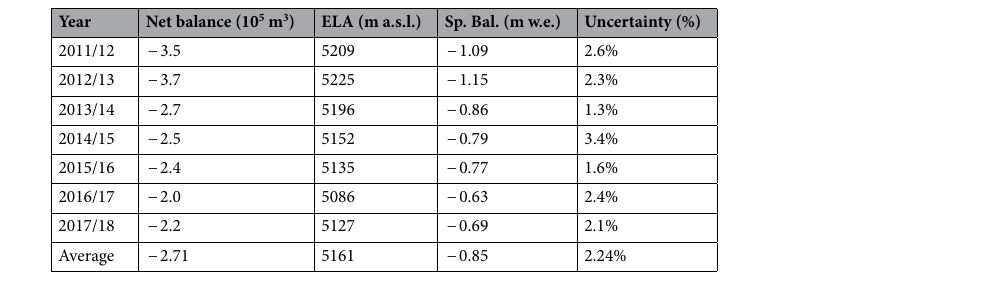
Table 1. Mass balance results for the period 2011–12 to